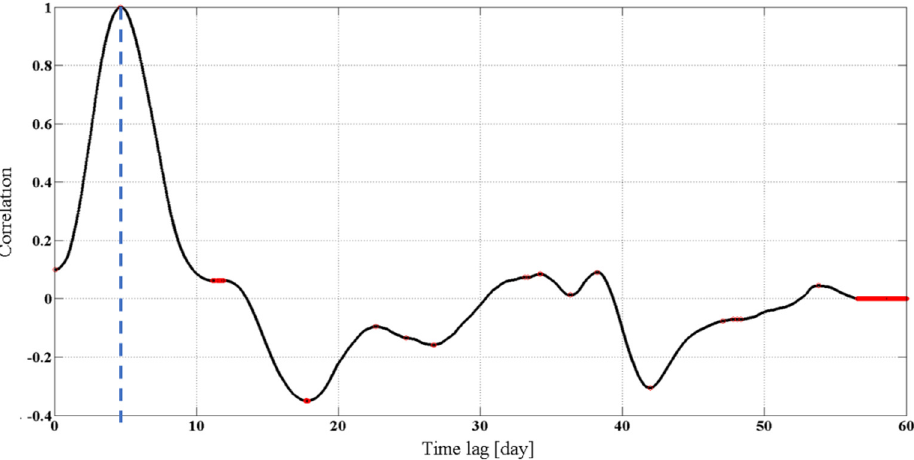
Figure 16. Normalised plot of correlation between the EC data series of the Rhône and the backfill as a function of time lag.